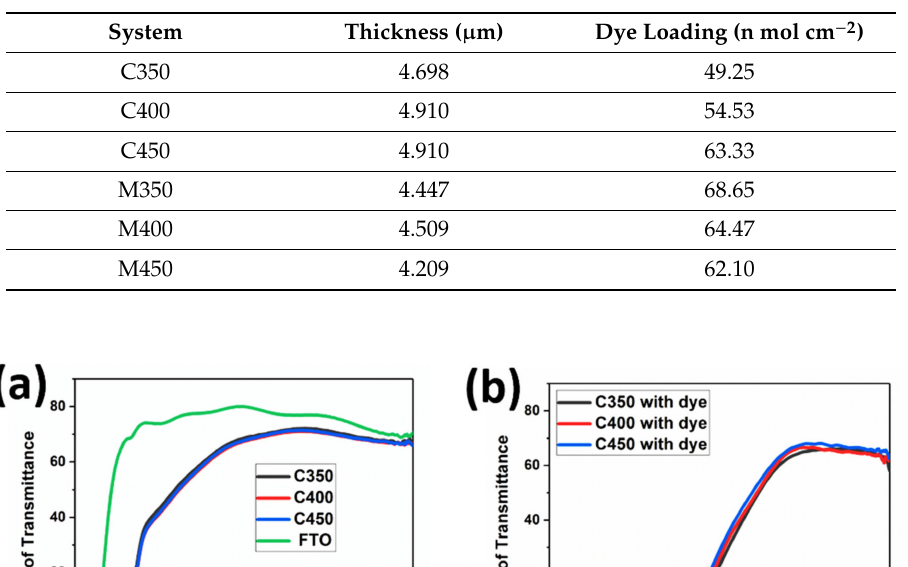
Table 2. The thickness and dye loading of the prepared films